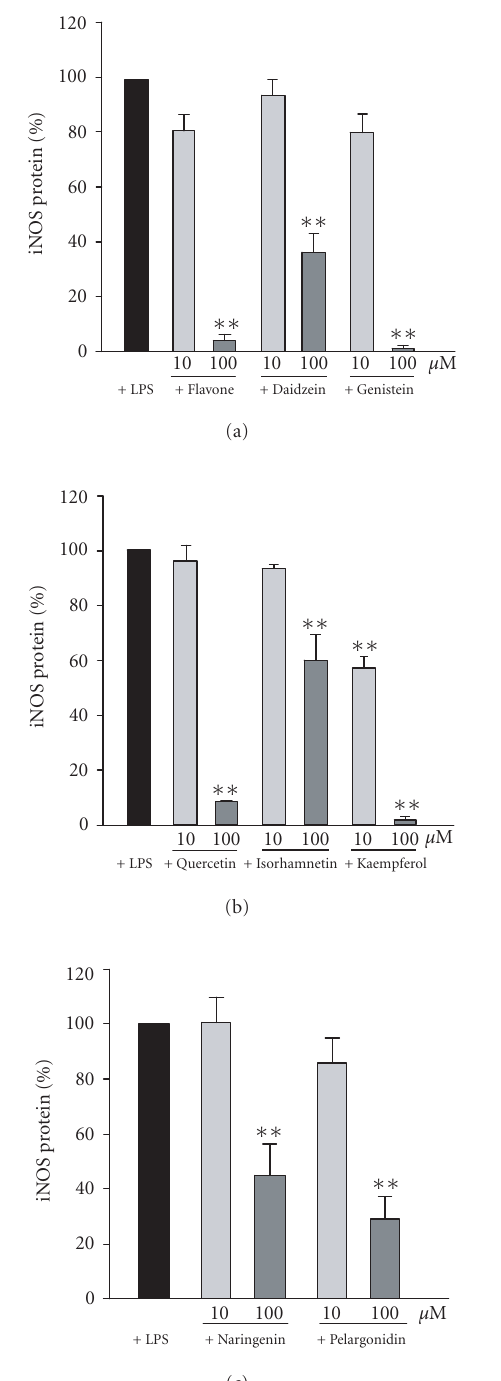
Figure 3: (a) E ff ects of flavone, daidzein, and genistein on LPS (100ng/ml)-induced iNOS protein expression in J774 cells dur- ing a 24-hour incubation time. (b) E ff ects of quercetin, isorham- netin, and kaempferol on LPS (100 ng/ml)-induced iNOS protein expression in J774 cells during a 24-hour incubation time. (c) Ef- fects of naringenin and pelargonidin on LPS (100 ng/ml)-induced iNOS protein expression in J774 cells during a 24-hour incubation time. iNOS protein expression was detected by Western blot. Mean + SEM, n = 3, ∗∗ P < . 01.